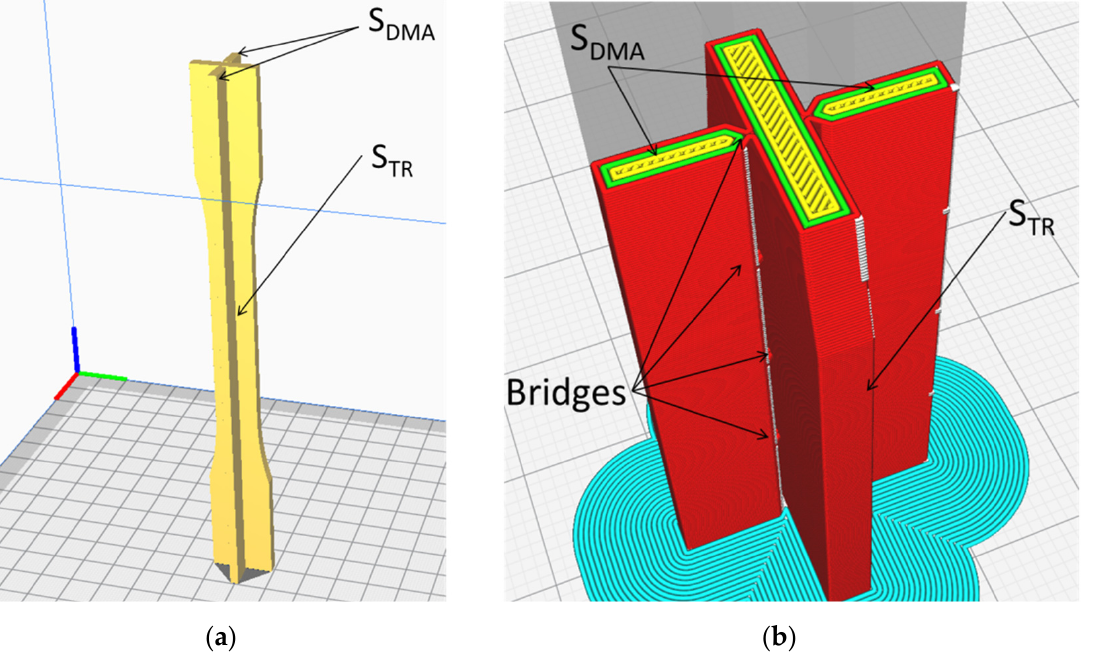
Figure 4. ( a ) Orientation and positioning of S TR and S DMA samples within the building volume and ( b ) detail of the bridge structures